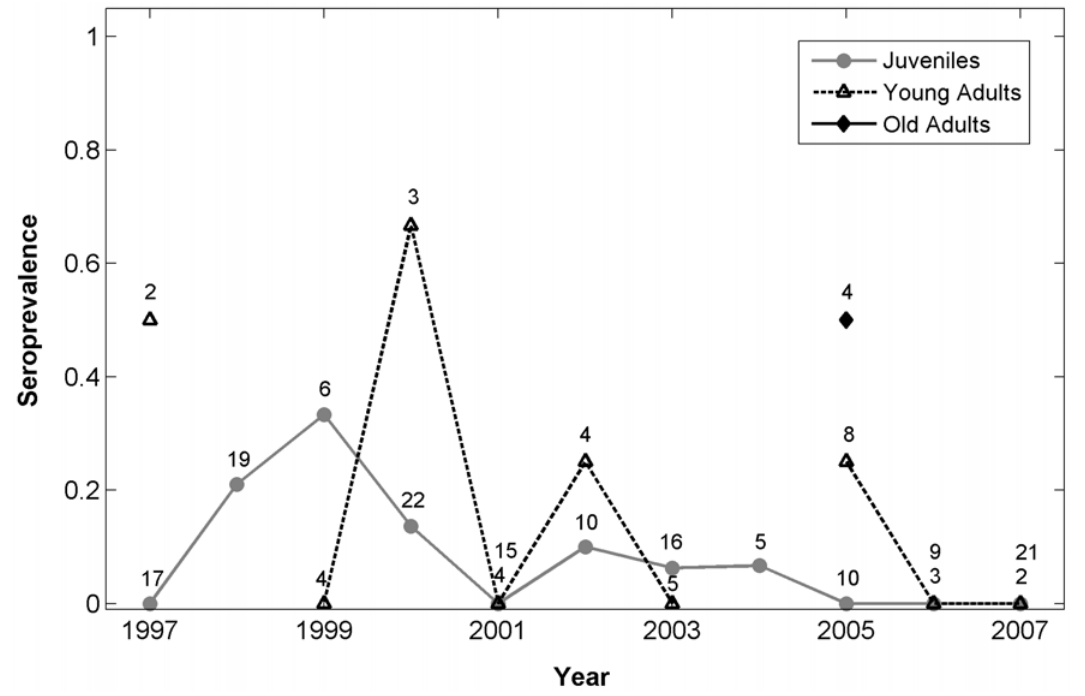
Figure 2. Neosporacaninum seroprevalence among wolves in Yellowstone National Park, 1997–2007. Data are divided by age class: juvenile (0.5–1.9 yrs), young adult (2–4.9 yrs), and old adult ( $ 5 yrs). Sample sizes are displayed above seroprevalences. Where points overlap, numbers refer to juveniles, young adults and old adults, respectively.